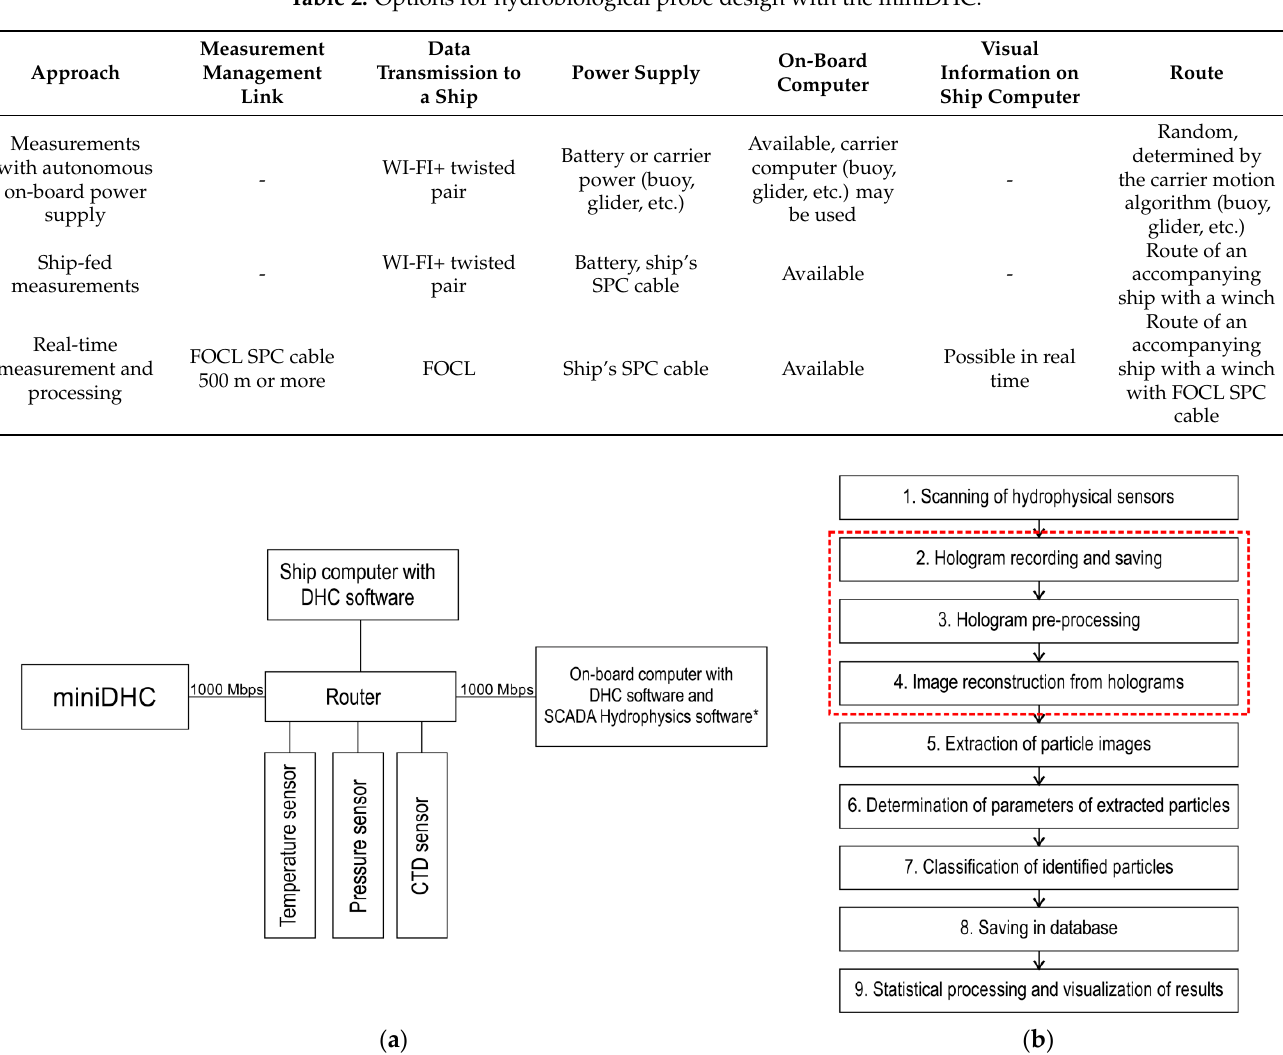
Table 2. Options for hydrobiological probe design with the miniDHC.